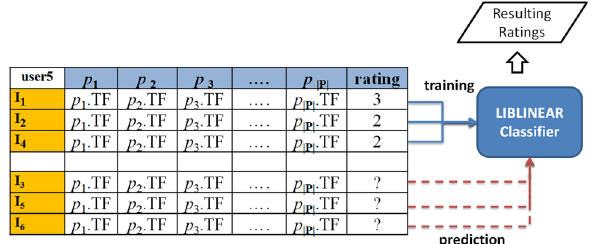
Fig. 11 Example of rating